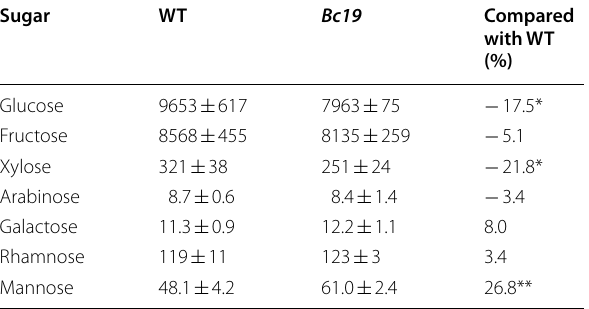
Table 1 Comparison of monosaccharides composition between the wild type (WT) and Bc19